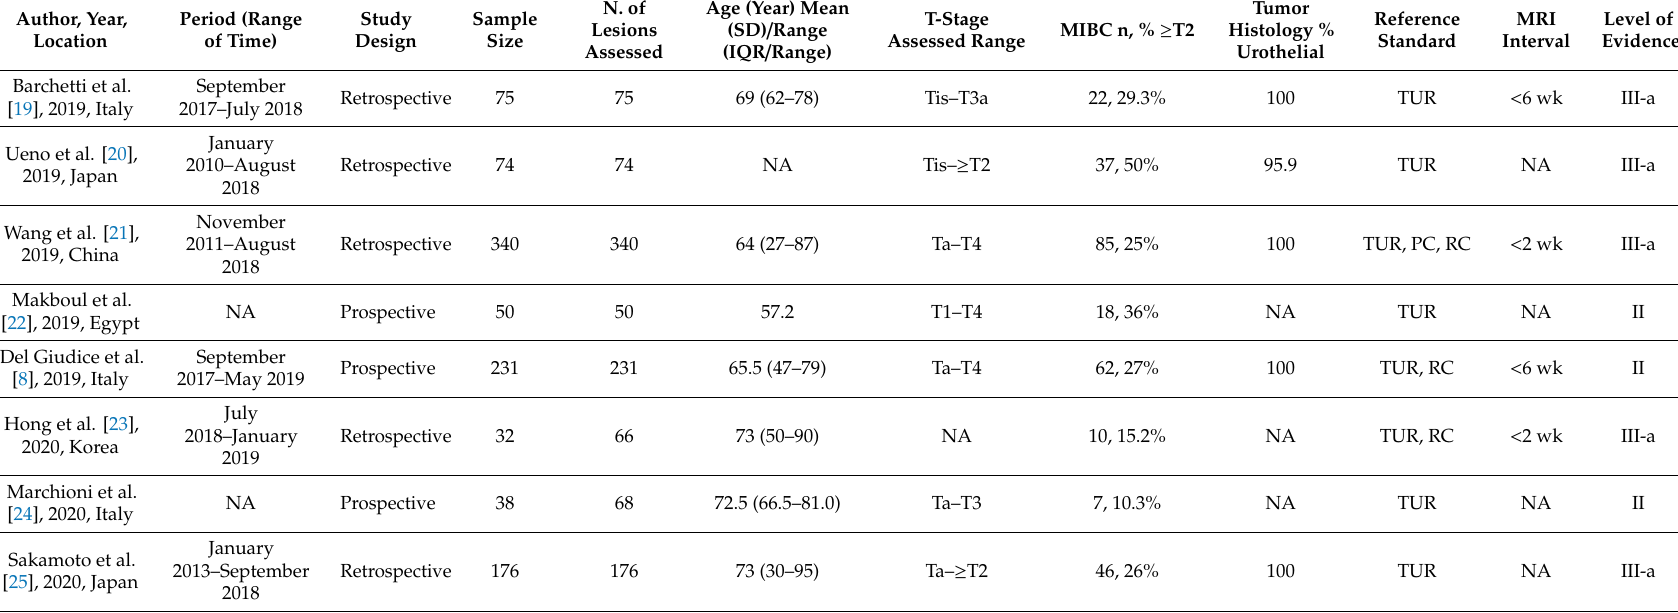
Table 1. Clinical and demographic characteristics of the studies enrolled in the systematic review and meta-analysis. SD, Standard Deviation, IQR, Inter Quartile Range; MIBC, Muscle Invasive Bladder Cancer; TUR, Trans-Urethral Resection; RC, Radical Cystectomy; NA, Not Applicable; PC, Partial